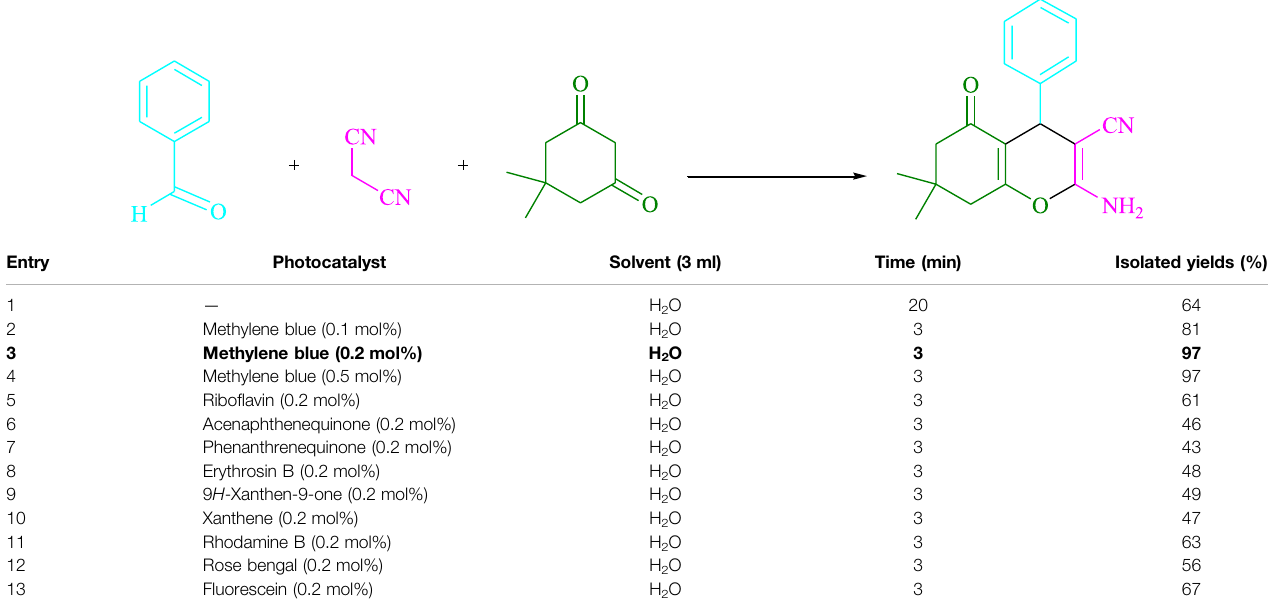
Frontiers in Chemistry |